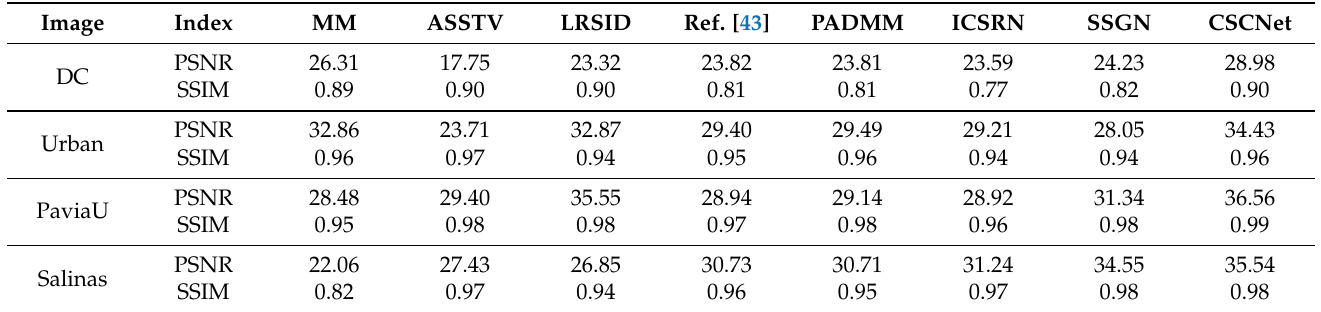
Table 1. PSNR and SSIM of the simulated image destriping